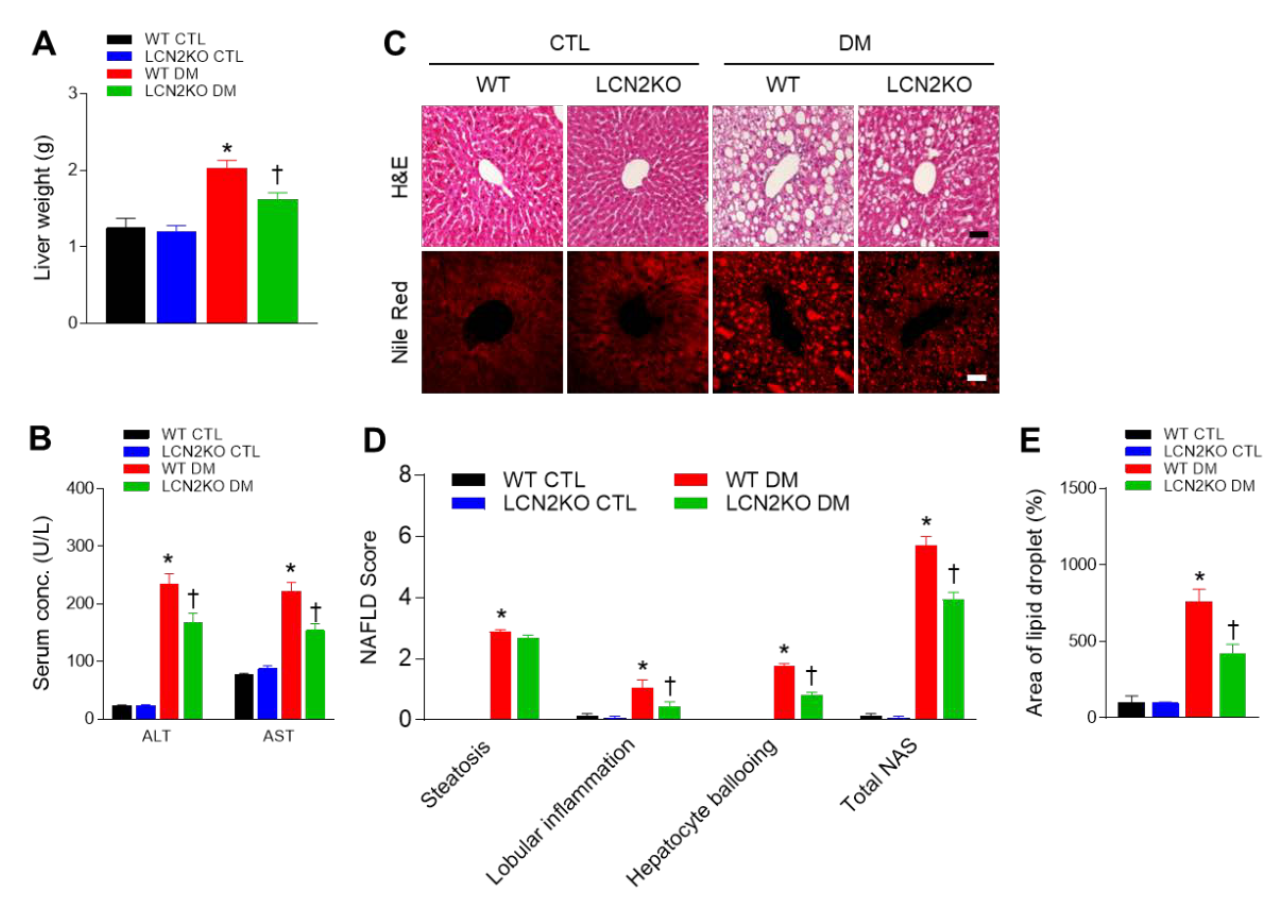
Figure 2. Effects of LCN2 deletion on hepatic steatosis in HFD/STZ-induced diabetic mice: ( A ) liver weight and ( B ) serum AST and ALT activity levels for each group; ( C ) representative images showing H&E and Nile red staining of liver sections; scale bar = 50 µ m; ( D ) histological NAFLD scores for each group; ( E ) percentages of Nile red-positive areas for each group; scale bar = 10 µ m. CTL: control; DM: diabetic mice. Data are presented as the mean ± SEM. The indicated p -values represent a two-way ANOVA, followed by Tukey’s post hoc test. * p < 0.05 vs. WT CTL. † p < 0.05 vs. WT DM.